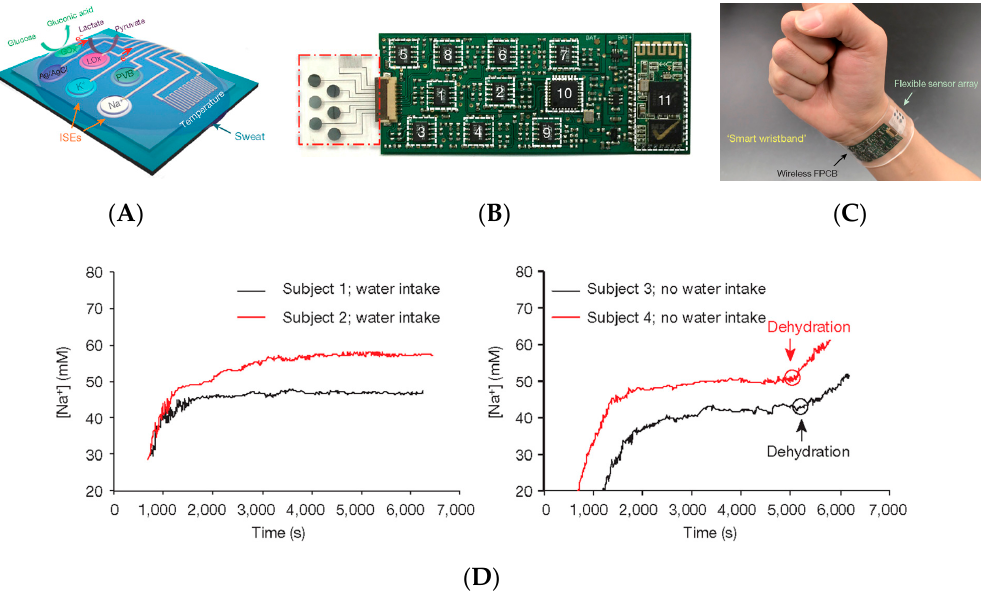
Figure 17. ( A )Schematicofthesensorarray, showingglucose, lactate, sodium, potassiumandtemperature sensors. ( B ) Photograph of a flattened flexible PCB, with the sensors array on the left, and the 11 electronic components on the right. ( C ) Picture of the active wristlet on a subject’s wrist. ( D ) Real-time sweat sodium and potassium levels during an endurance run with (left) or without (right) water intake. Dehydration is diagnosed in the latter case. Reproduced from [59] with permission. Copyright © 2016, Springer